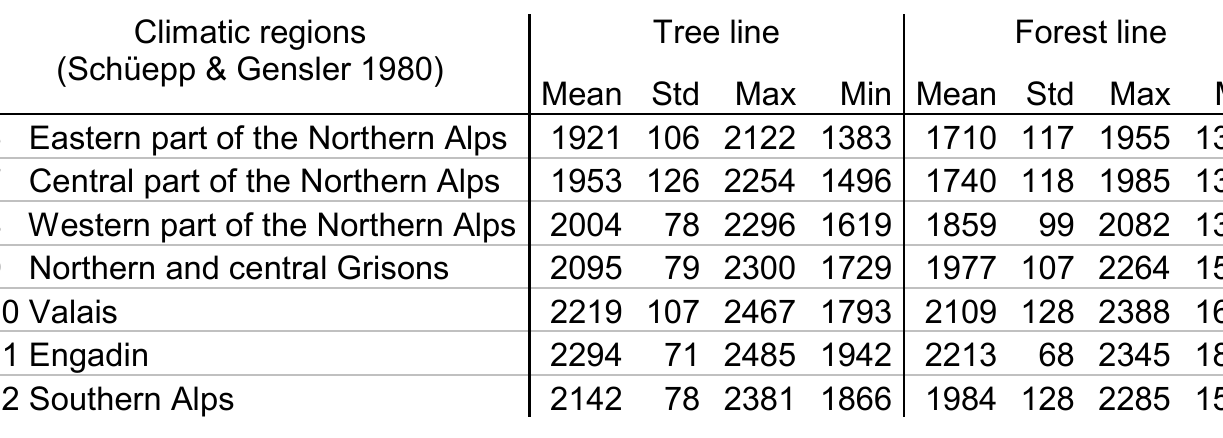
Table 1: The altitudes of the tree line and forest line were determined for the major climatic regions of Switzerland in m. a. s.